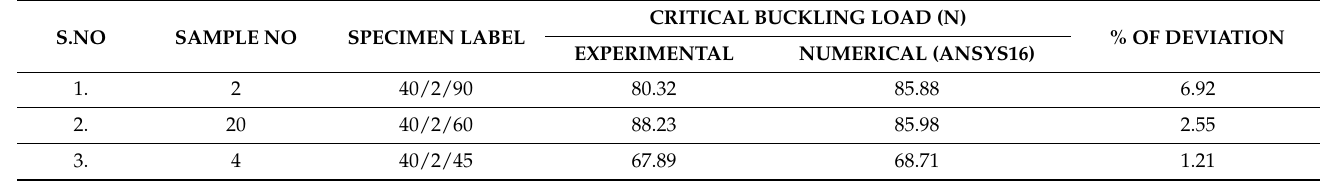
Table 7. Comparison table of critical buckling loads obtained experimentally and numerically using ANSYS16 .